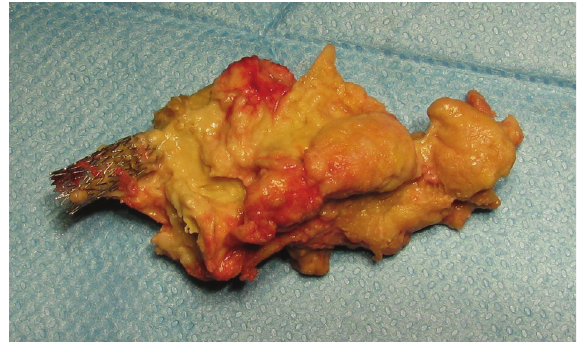
Figure 3: Biopsy specimen, with the carotid stent seen invaded and occluded by the